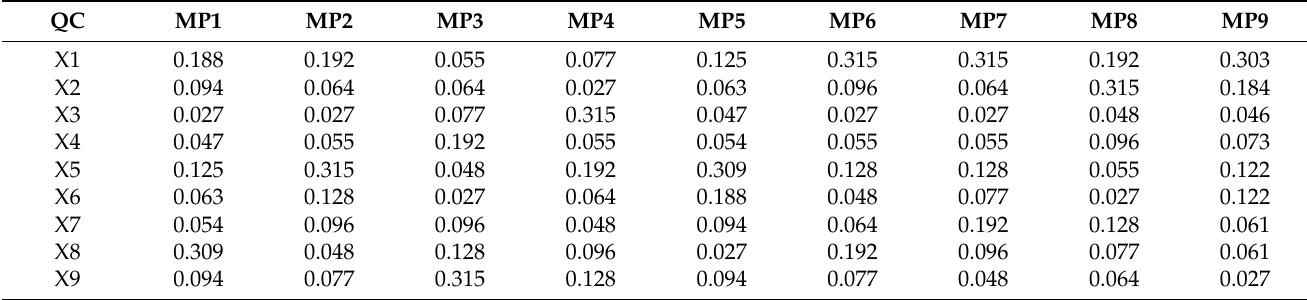
Table 9. Weights of experimental responses with respect to individual